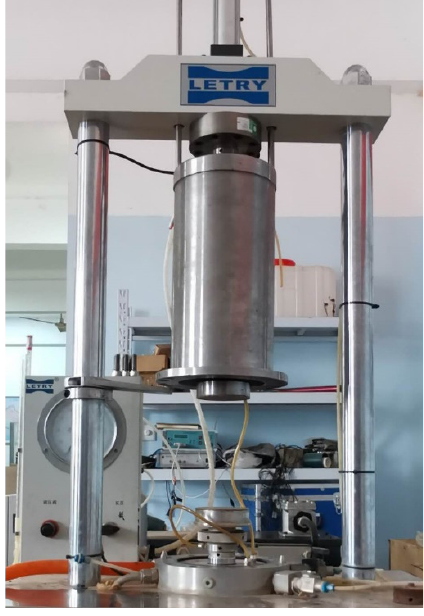
Figure 3. The close-up photo of the triaxial apparatus used for laboratory monotonic and cyclic triaxial tests.